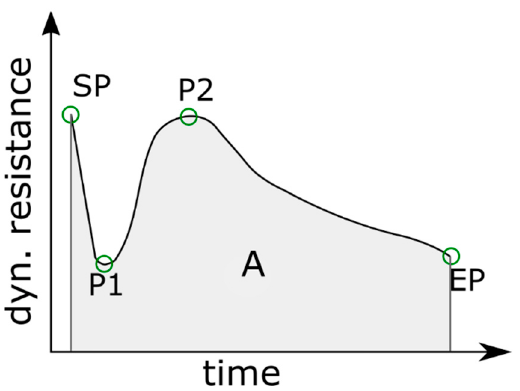
Figure 3. Typical DR curve for steel. The following features are marked: starting point (SP), peak no. 1 (P1), peak no. 2 (P2), end point (EP), and area (A) under the